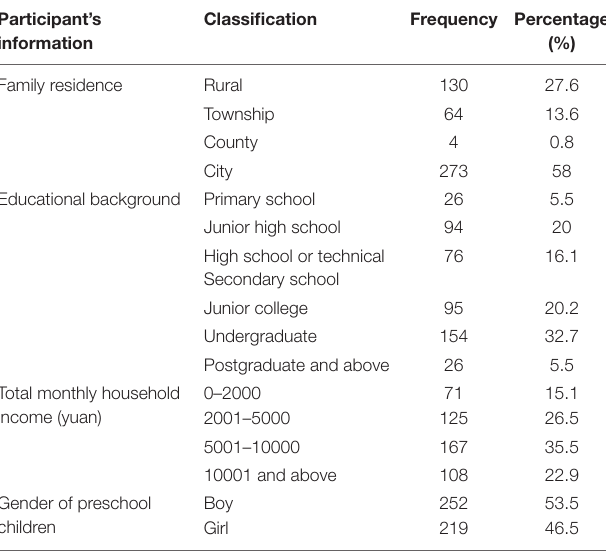
TABLE 2 | Basic participant information in Study 3 ( n = 471).